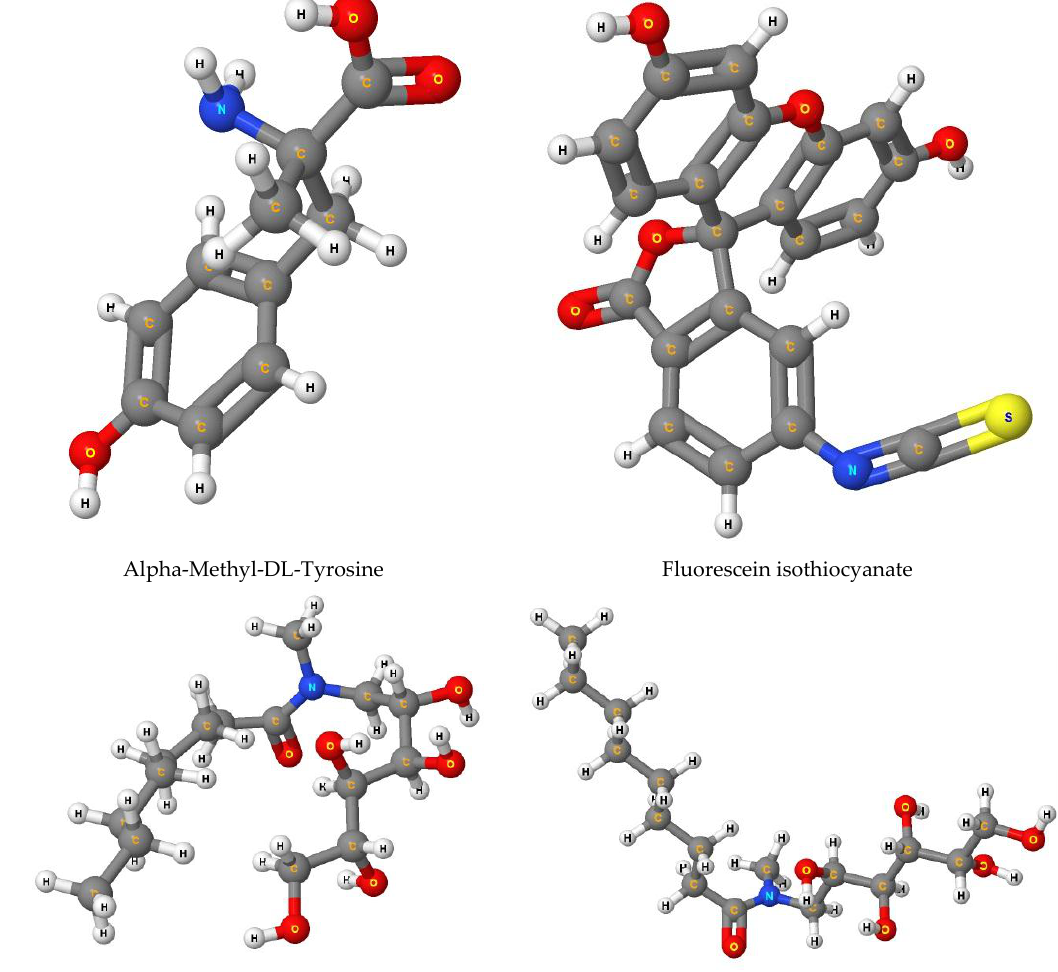
Figure 7. 3-D Optimized structures of organic compounds from the Euclidean Search hit-list of P. muellerianus leaf-extract FT-IR spectrum. P. muellerianus leaf-extract FT-IR